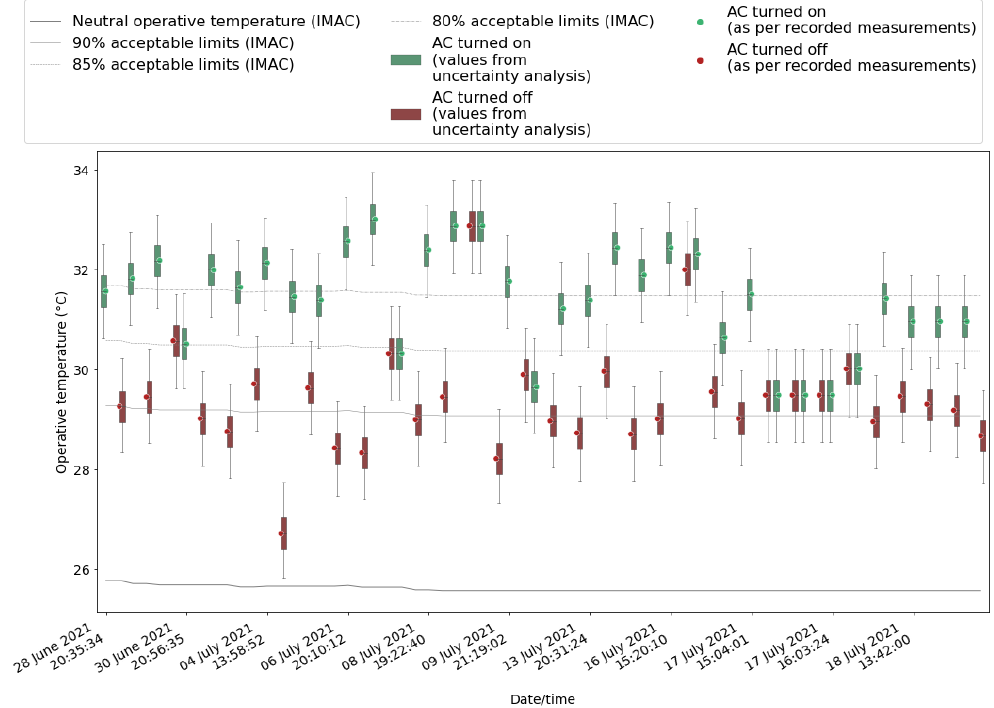
Figure 7. Relation between thermal comfort as per IMAC for mixed-mode building and AC on and off status. Table 5. Assumed ranges of values for calculating uncertainty in